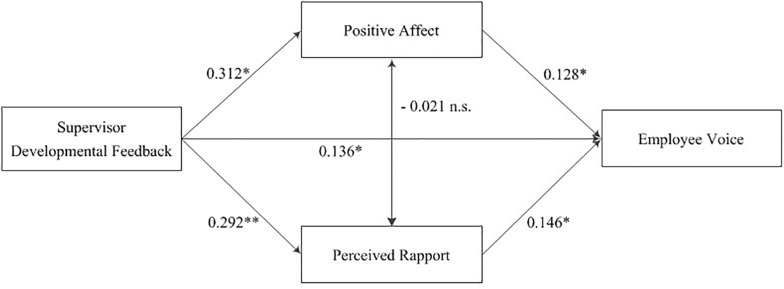
Conceptual model.